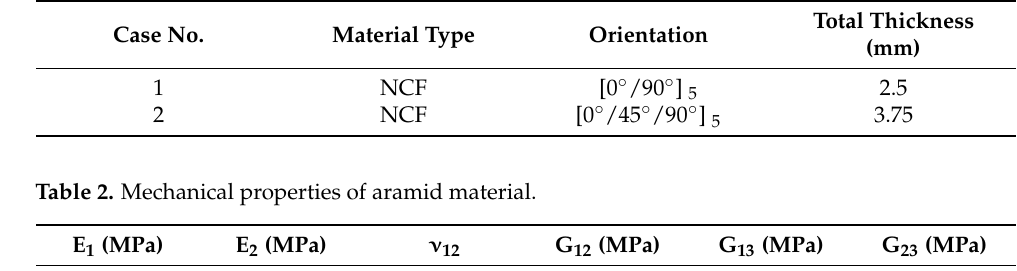
Table 1. Structural design result of hull.